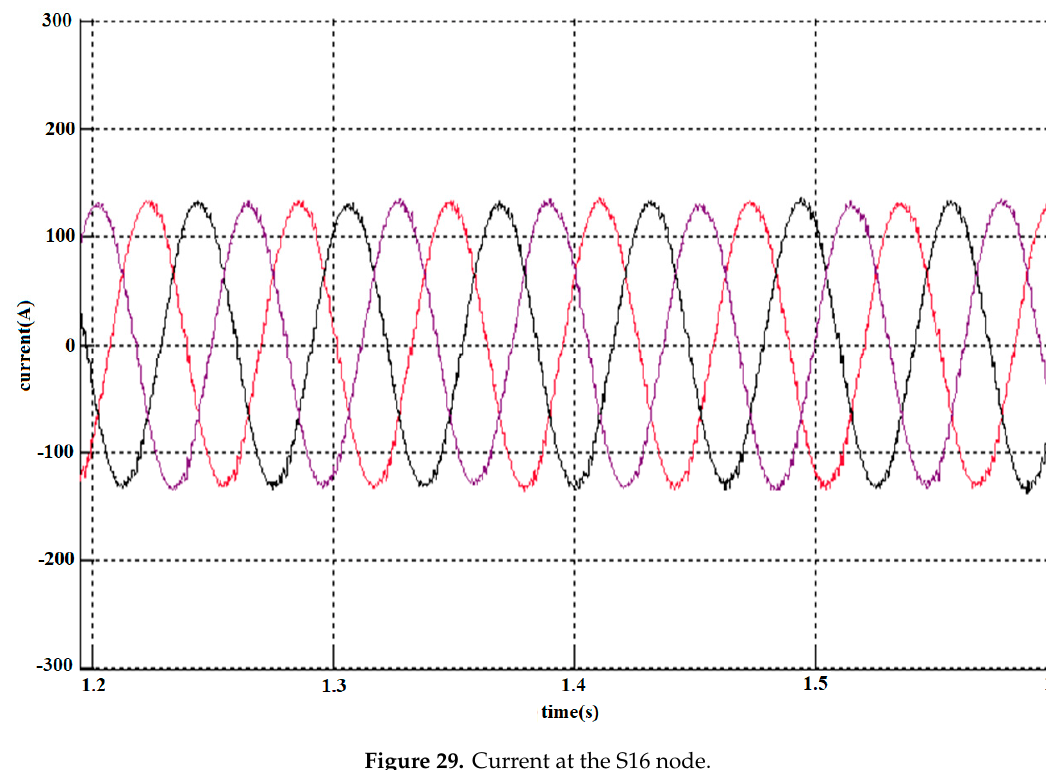
Figure 29. Current at the S16 node. Electronics 2020 , 9 , 61